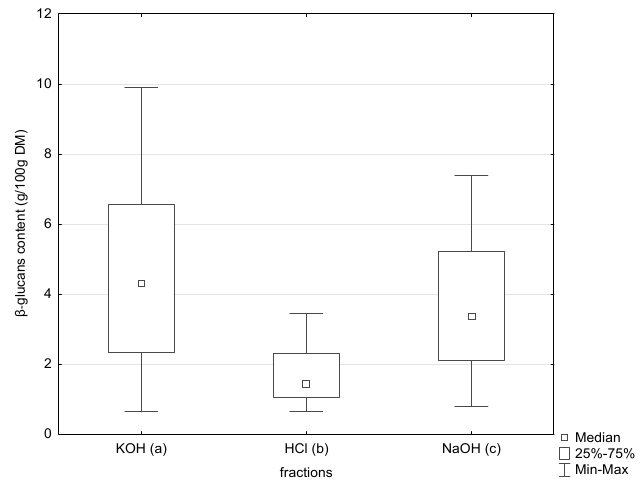
Figure 1. Content of β -glucans in three tested fractions (KOH, HCl and NaOH) using the Congo red method by Nitschke et al. [29]; p a/b <0.0001; p b/c <0.0001; p a/c <0.0001 .